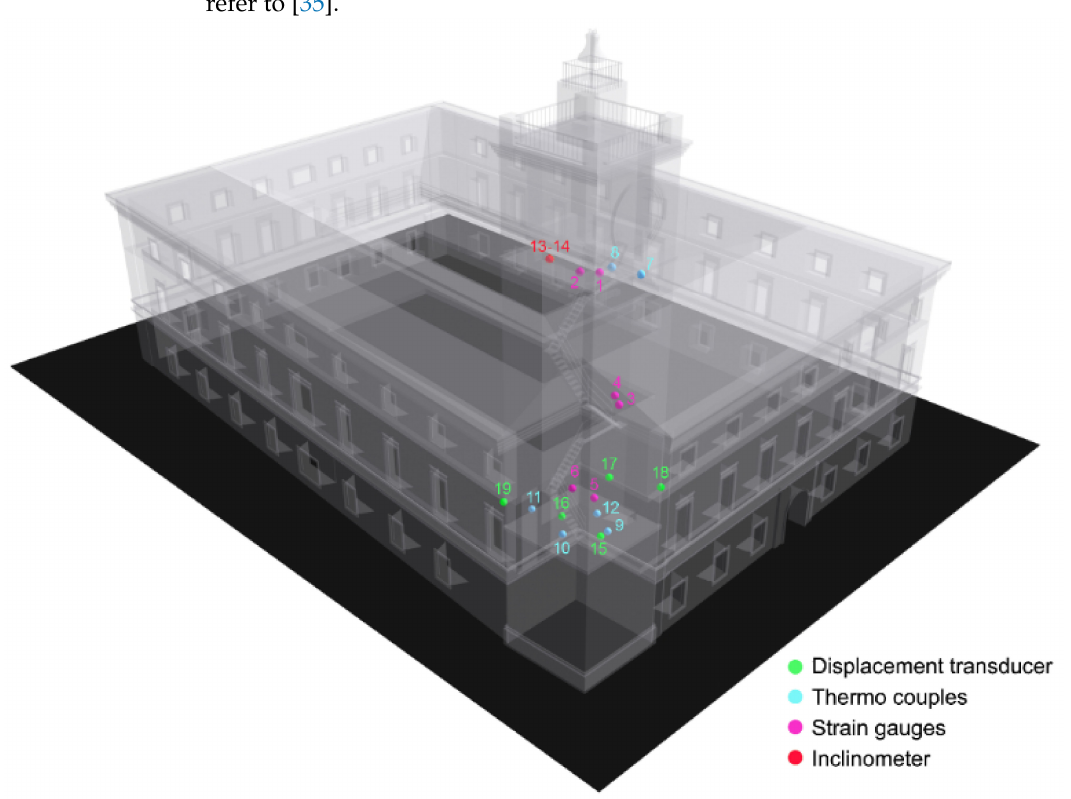
Figure 4. Layout of the static monitoring